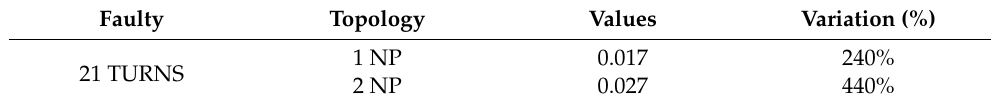
Table 3. ZVF values for two different stator topologies with 21 shorted turns. Table 2. ZVF values for two three-phase systems with 21 shorted turns.